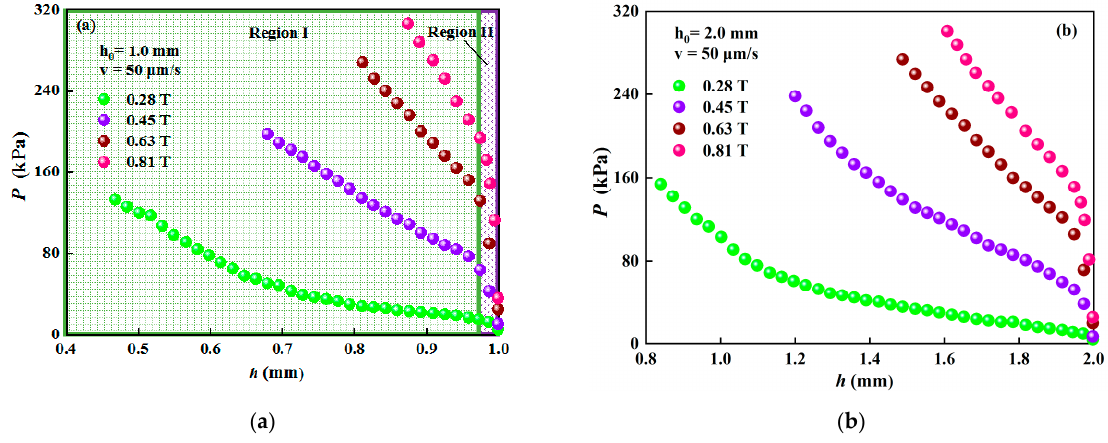
Figure 4. The compressive stress versus the instantaneous gap distance under different magnetic fields at v = 50 μ m/s. ( a ) h 0 = 1 mm; ( b ) h 0 = 2 mm.